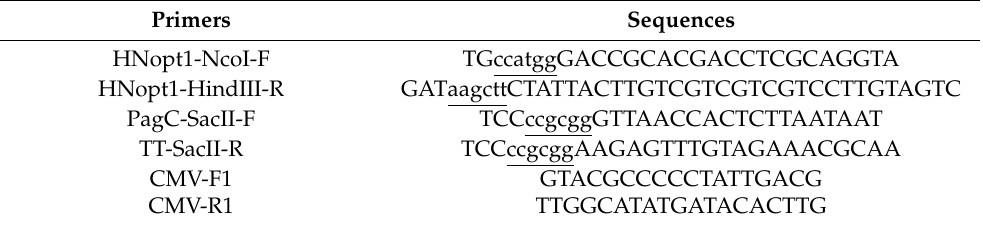
Table 2. Primers used in this